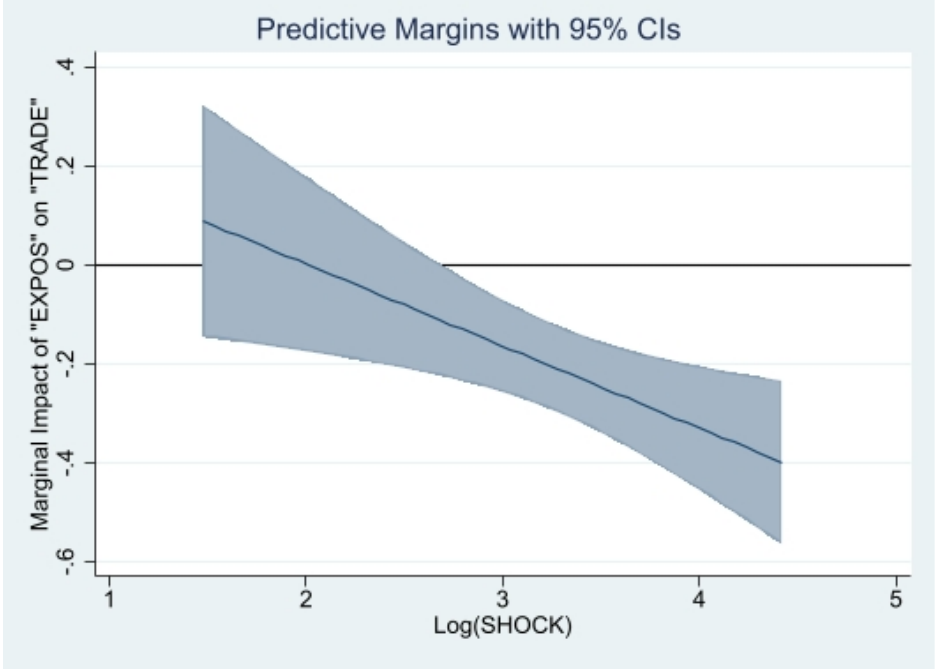
Figure 5. Marginal Impact of “EXPOS” on “TRADE” for varying levels of shocks. Source: Author.